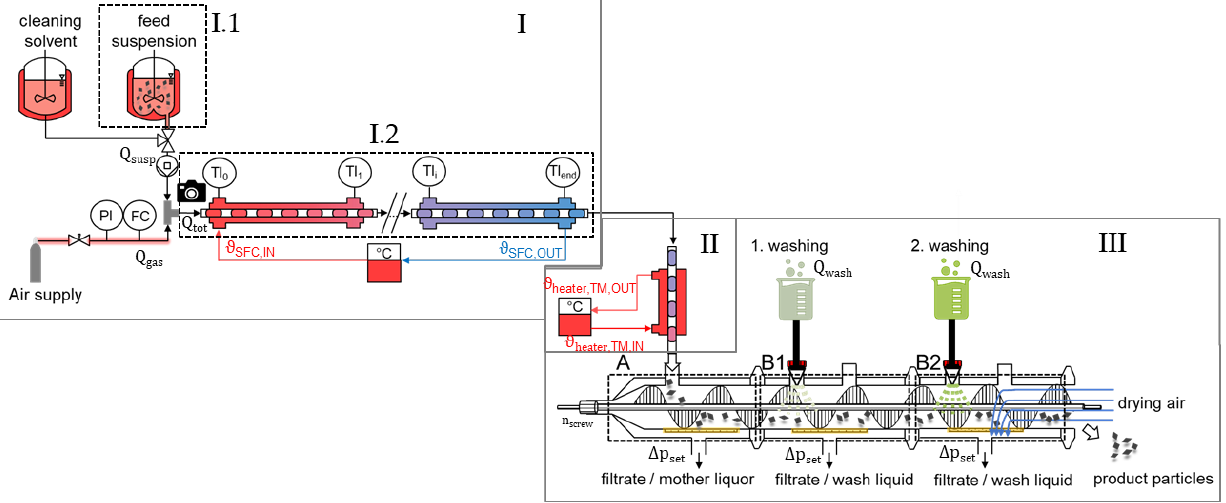
Figure 2. Schematic experimental setup for continuous small-scale manufacturing consisting of a slug flow crystallizer (SFC, ( I )), a heater ( II ) and the continuous vacuum screw filter (CVSF, ( III )). A corresponding photograph is given in the supplementary materials in Figure